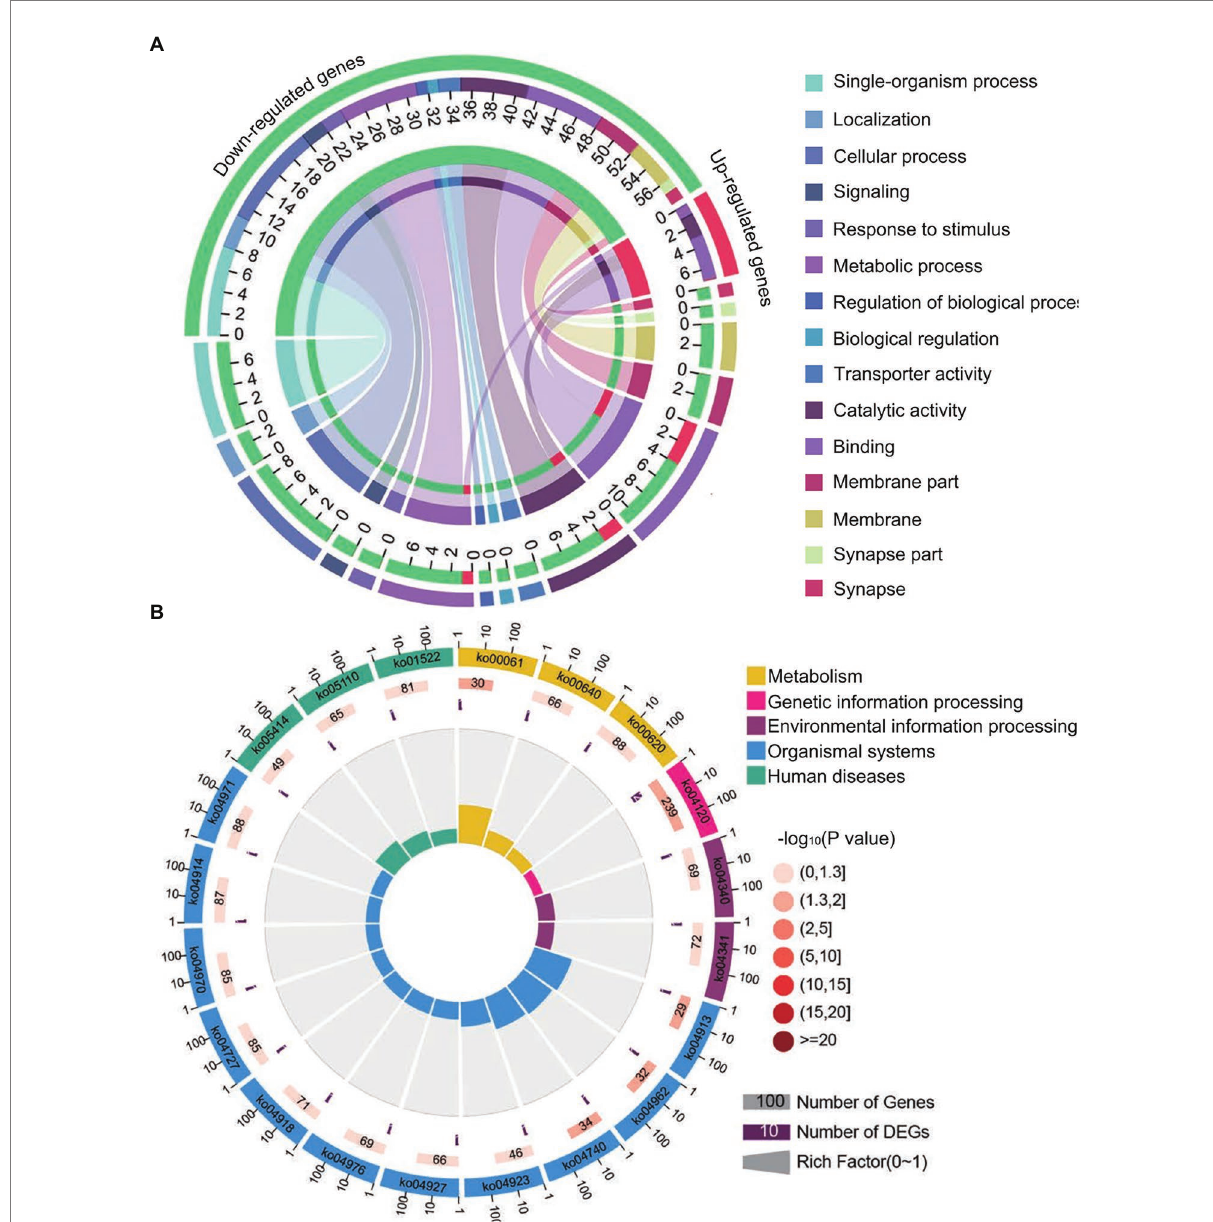
FIGURE 8 Database annotation of shared A. c. cerana DEmRNAs targeted by N. ceranae DEmiRNAs. (A) GO database annotation of DEmRNAs shared by AcCKm7 vs. AcTm7 and AcCKm10 vs. AcTm10. (B) KEGG database annotation of down-regulated mRNAs shared by AcCKm7 vs. AcTm7 and AcCKm10 vs.